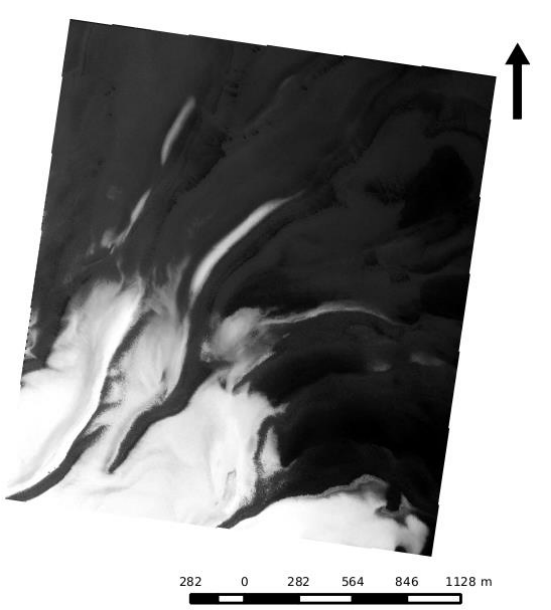
Figure 3. HRSC Image h2162_0000, lines 1-15000 processed with DLR-VICAR, orthorectified to a DTM produced with the Kim & Muller (2009) Modification